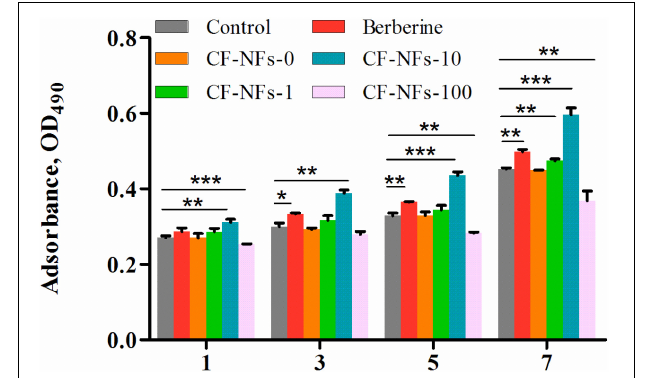
FIGURE 4 | Water contact angle measurements of electrospun nanofiber membrane and its component materials PCL and PVP. * P < 0.05, ** P < 0.01, *** P < 0.001.